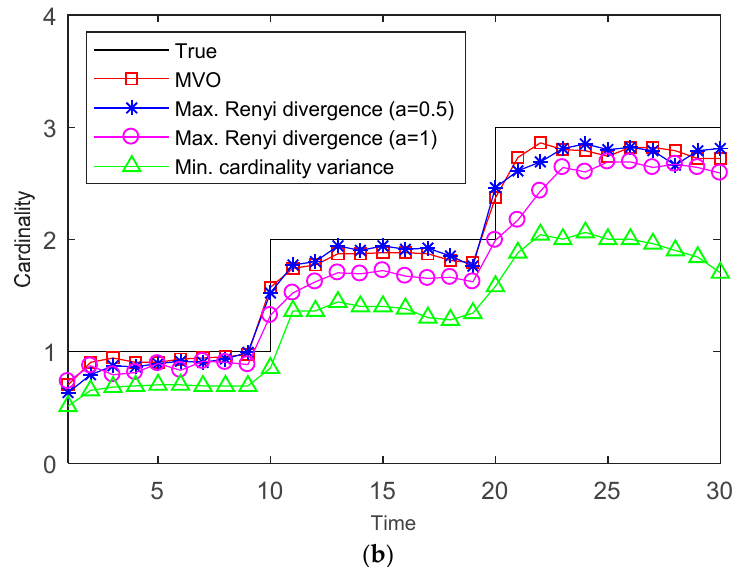
Figure 5. OSPA distances and cardinality estimates versus time: ( a ) OSPA distance; ( b ) Cardinality estimates.